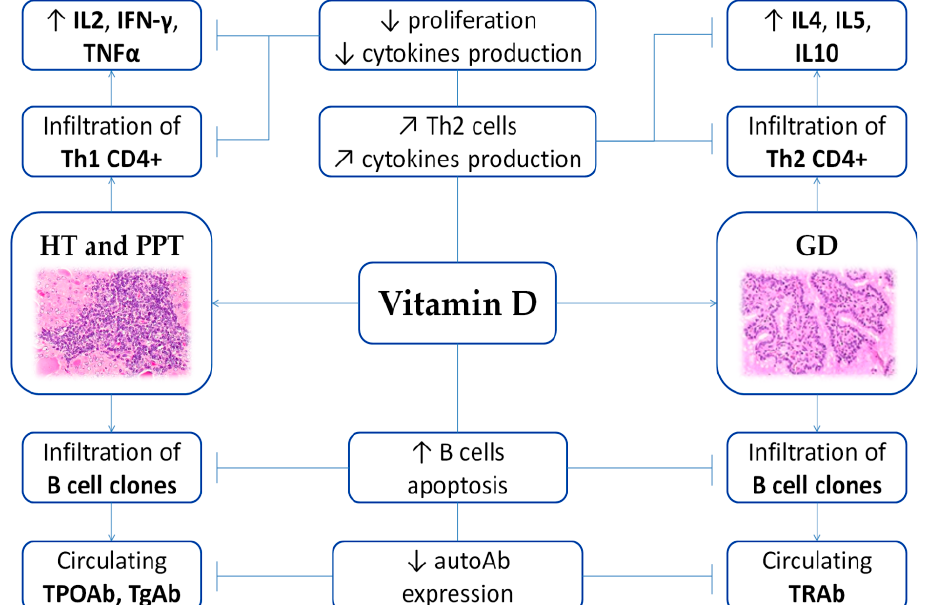
Figure 2. Scheme of the immunomodulating role of vitamin D on AITD. Arrows illustrate increase ( ↑ ), decrease ( ↓ ) or regulation/modulation ( ↗ ) of specific actions, processes, cells, or molecules. Abbreviations: autoAb, autoantibodies; GD, Graves’ disease; HT, Hashimoto’s thyroiditis; IFN, Interferon; IL, Interleukin; PPT, Post-partum thyroiditis; Th, T helper; TNF, Tumor Necrosis Factor; TPOAb, anti-thyroid peroxidase antibodies; TgAb, anti-thyroglobulin antibodies; TRAb, TSH receptor autoantibodies. Histological images are available at Histology Gallery, Yale Medical Cell Biology.